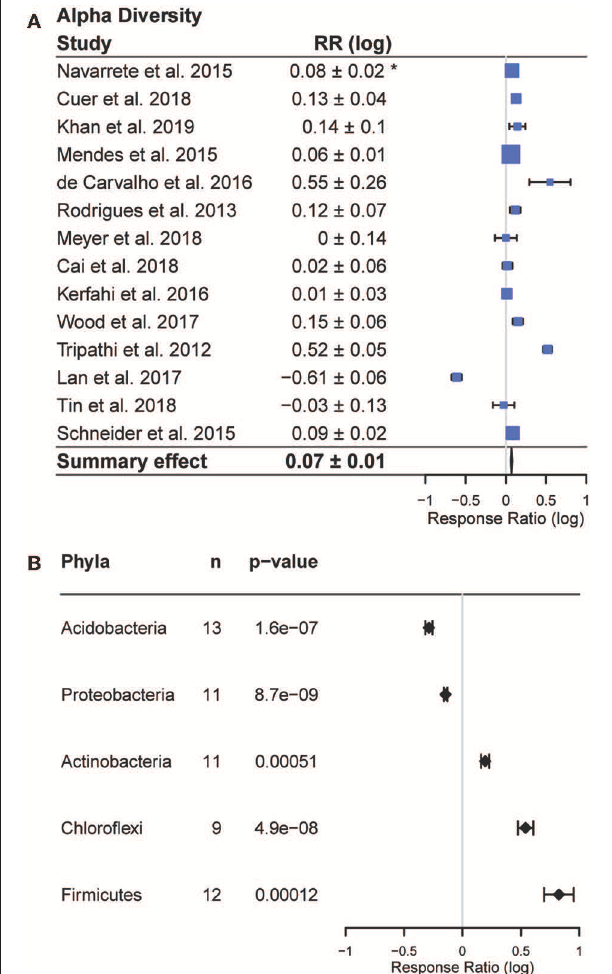
FIGURE 3 | Effects of forest to agriculture conversion on bacterial diversity and composition. (A) Changes in alpha diversity measured as the response ratio (RR). Positive values indicate higher diversity in agricultural areas and negative values indicate higher diversity in forest areas. The bars represent the 95% confidence intervals (CIs) and box size corresponds to study weight in the summary effect size. Summary response ratio was significantly different from zero (two tailed t -tests, p < 0.001). (B) Changes in abundance of phyla reported in a majority of studies, including the number of studies reporting each phylum out of 16 studies. *Confidence interval (95%) of the response